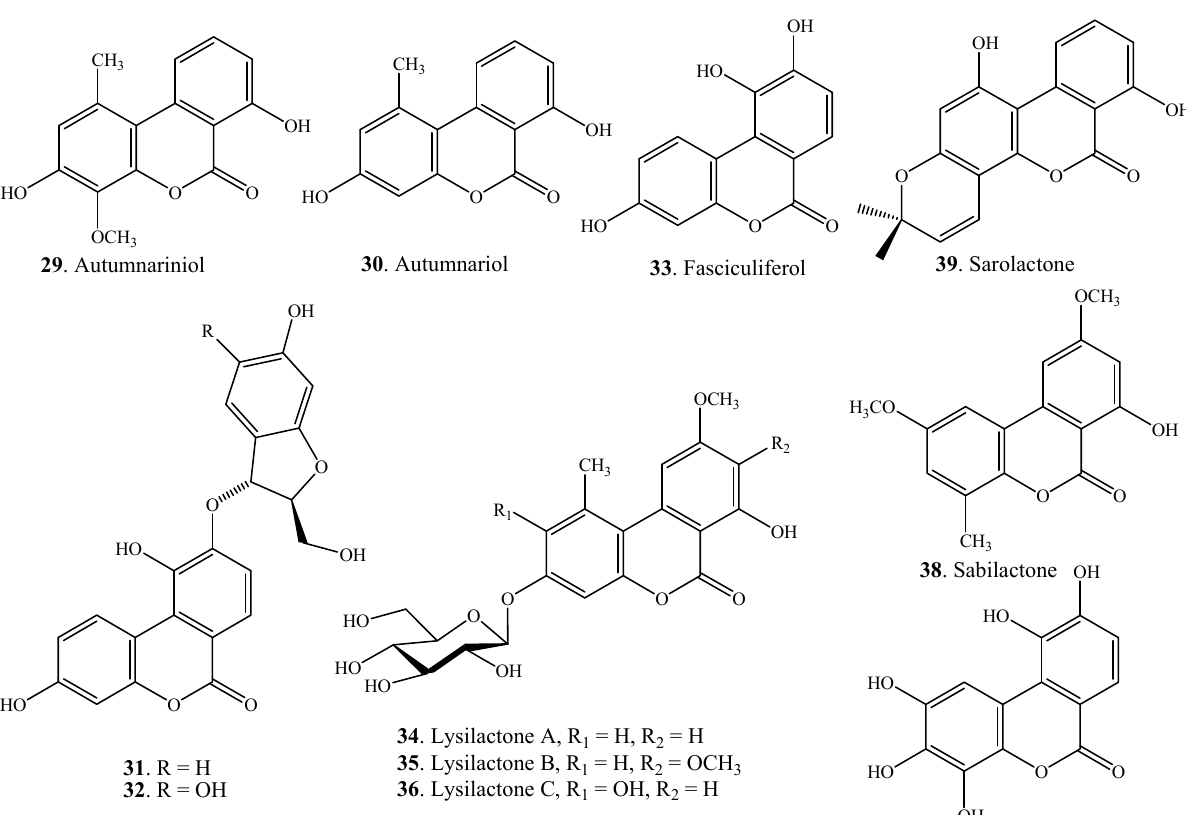
Figure 4. Structures of the dibenzo- α -pyrones from